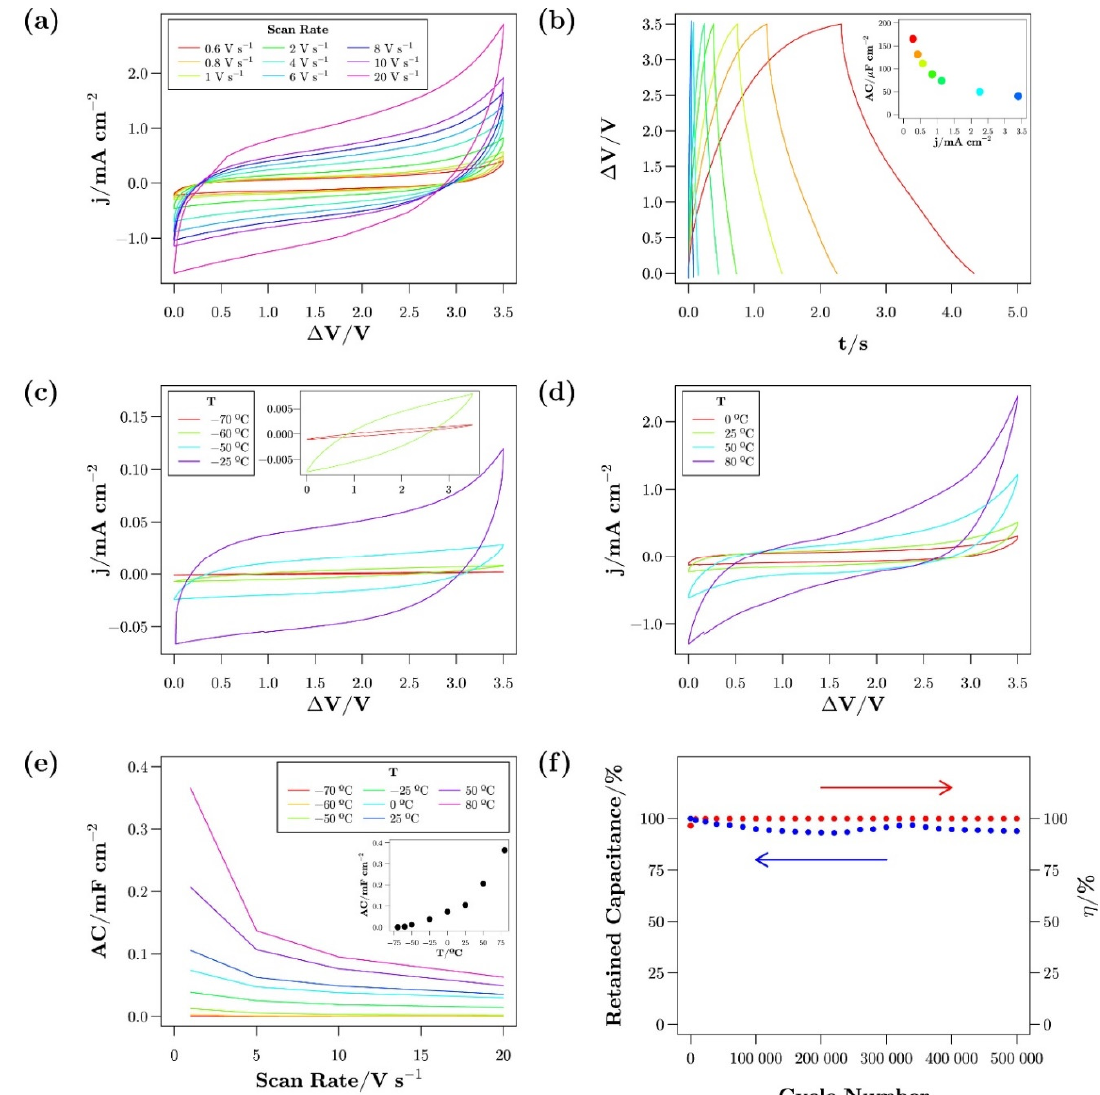
Figure 9. Electrochemical characteristics of Ni-foam SCs at different operating temperatures. ( a ) Cyclic voltammogram with different scan rate. ( b ) Galvanostatic charge–discharge profile. The inset shows the AC as a function of the current density. ( c ) Cyclic voltammogram at low temperatures. ( d ) Cyclic voltammogram at medium–high temperatures. ( e ) AC as a function of the scan rate obtained at different temperatures ranging from − 70 °C up to 80 °C. ( f ) Cycling stability (blue points) and coulombic efficiency (red points) at ambient condition. Reprinted 2018 from [91] with permission from Elsevier.